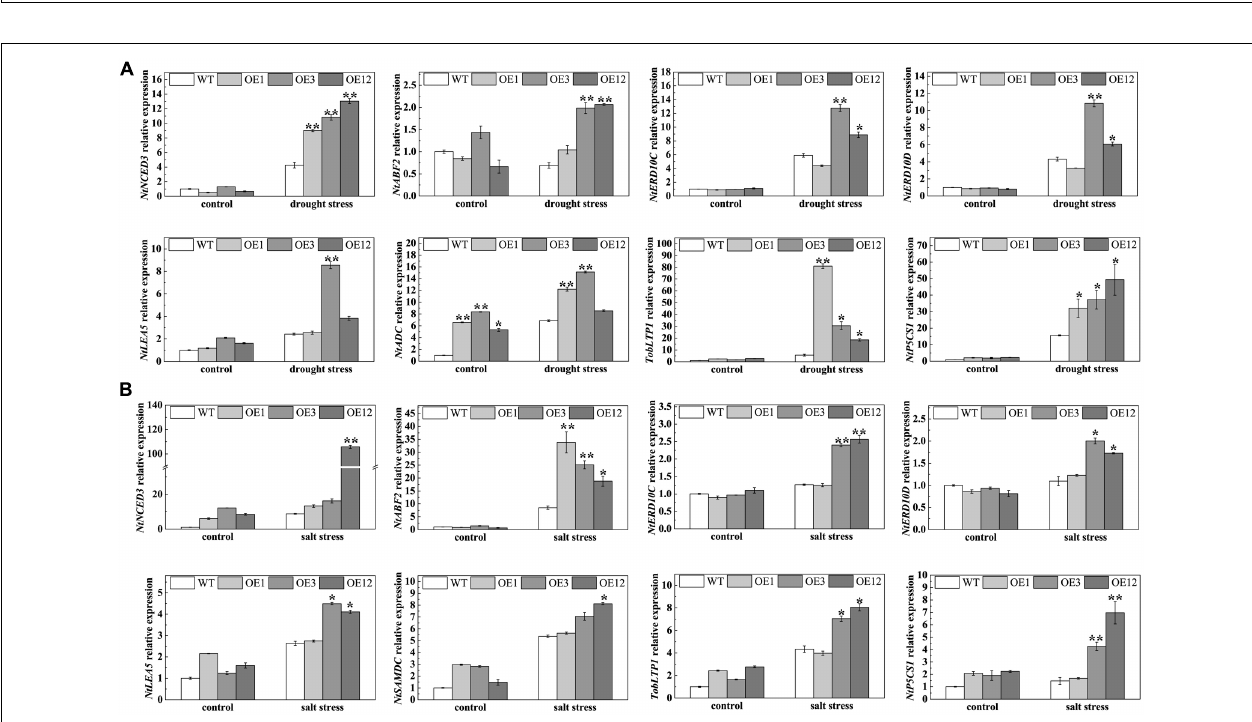
FIGURE 9 | Expression analysis of stress-related genes. (A,B) Expression levels of stress-related genes in tobacco seedlings after treatment on 1/2 MS media with 300 mM mannitol or 150 mM NaCl for 1 week. Three independent biological replicates were performed and produced similar results. Vertical bars refer to ± SE ( n = 3). Asterisks indicate significant difference between the WT and the transgenic lines ( ∗ P < 0.05; ∗∗ P < 0.01).